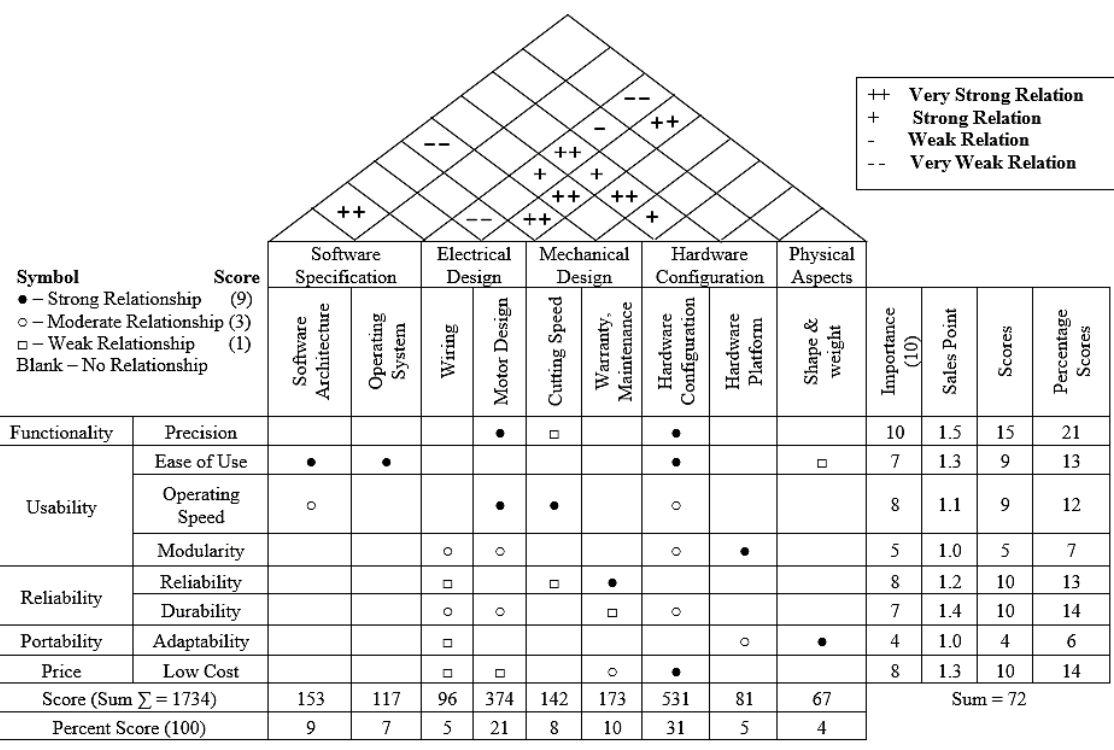
Figure 1. HOQ for CNC PCB